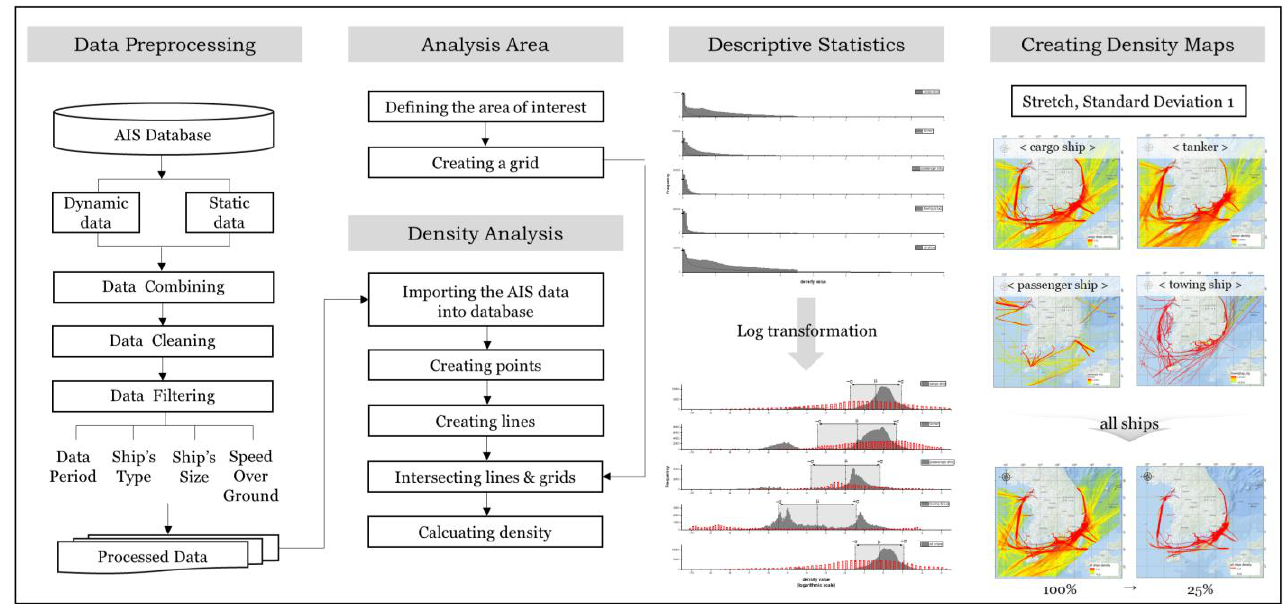
Figure 1. Flowchart of the proposed maritime traffic density analysis using an automatic identification system (AIS) data and density map creation.